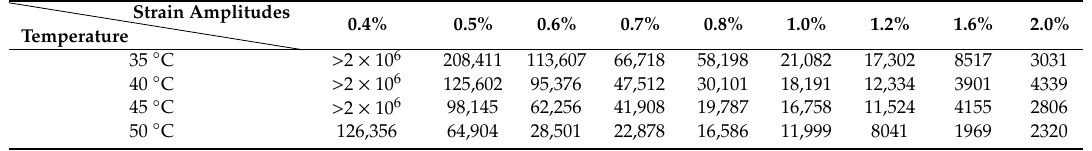
Figure 3. Fatigue life curves at di ff erent temperatures for various strain amplitudes. Table 3. Fatigue life of SMA